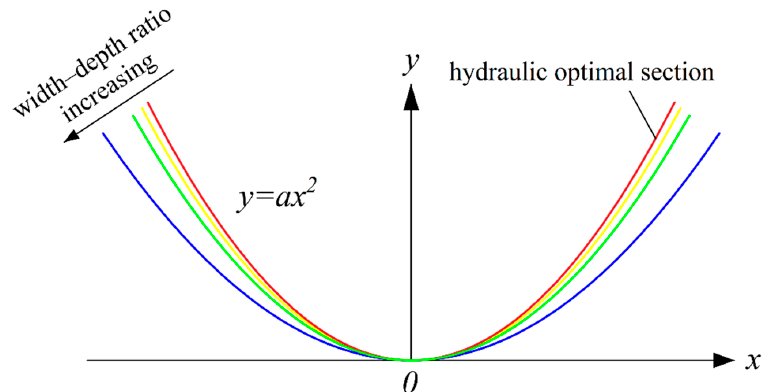
ff erent width–depth ratios.